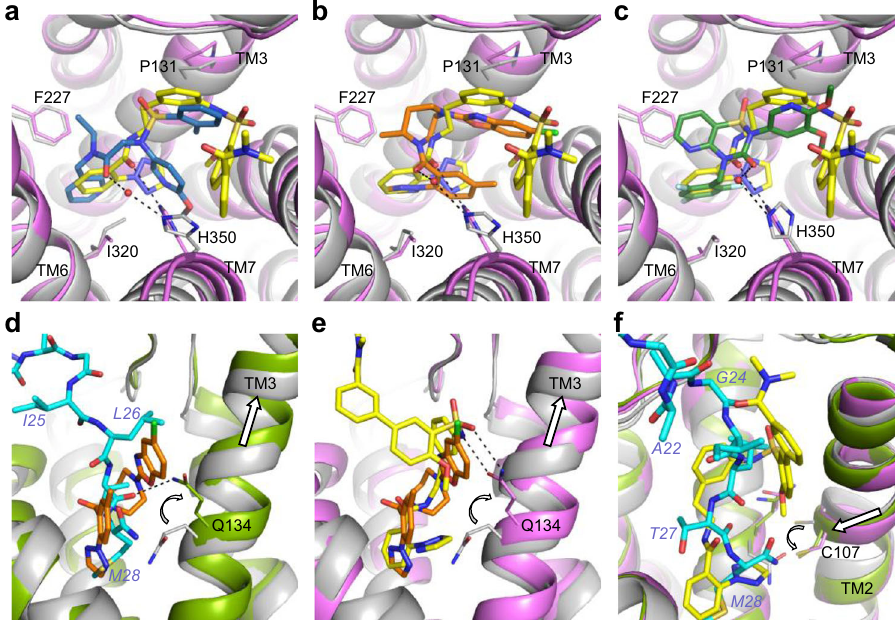
Fig. 5 Comparison of agonist and antagonist binding. Superpositions of OX 2 R in inactive (gray) and active (green and purple) conformations. a – c Comparison of the binding mode of compound 1 (yellow) and those of the antagonists EMPA (blue; PDB ID 5WQC), suvorexant (orange, 4S0V), and HTL6641 (dark green; 6TPN), respectively. Water molecules mediating interactions with the sidechain of H350 7.39 in the antagonist-bound complexes are rendered as red spheres. d – f Conformational changes (white arrows) in TM2, TM3, Q134 3.32 , and C107 2.56 upon activation by OxB (cyan) and compound 1 are highlighted by white arrows.